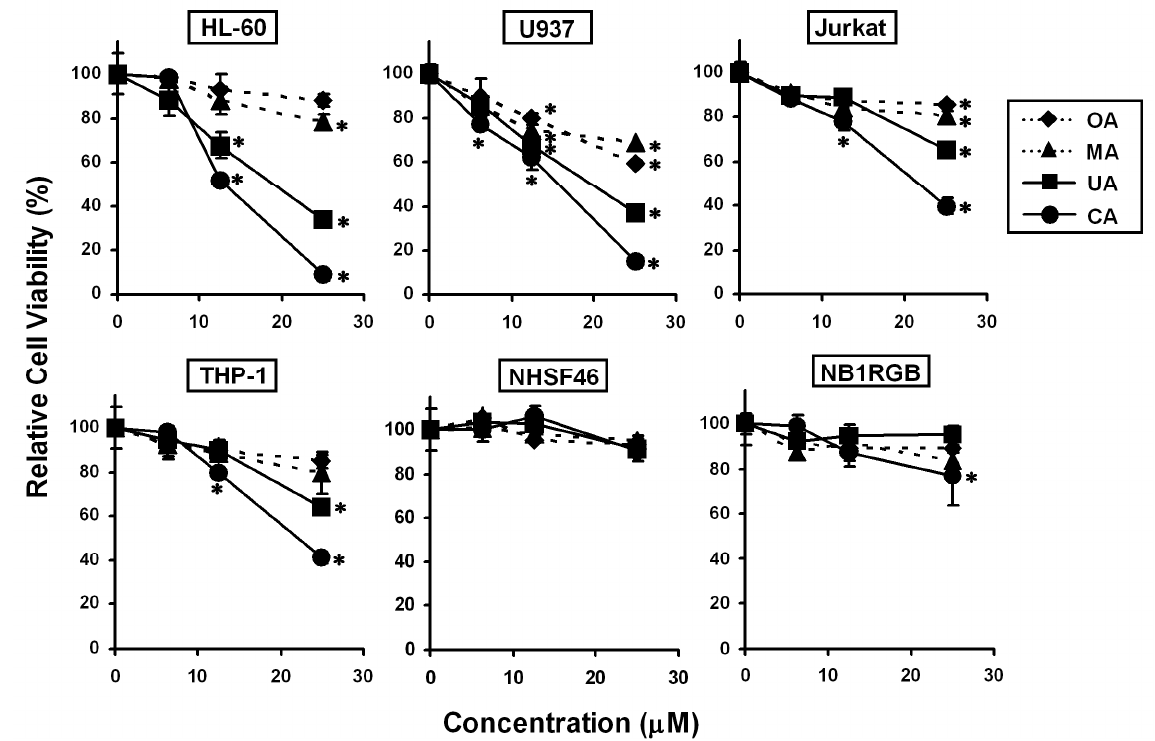
5.2% (control) to 16.4% (12 h) and 61.6% (24 h), gradually (Figure 4C). Overall, these results clearly indicate that CA exerted its anti-proliferative effect via the induction of apoptotic cell death. Figure 3. Effects of the four triterpenes on cell proliferation in human leukemia and normal skin fibroblast cell lines. Cells were treated with CA, UA, MA and OA at various concentrations for 24 h, and the cell viability was determined using the MTT assay. The data represent the mean ± S.D. for three individual experiments. * p < 0.05 compared with the control